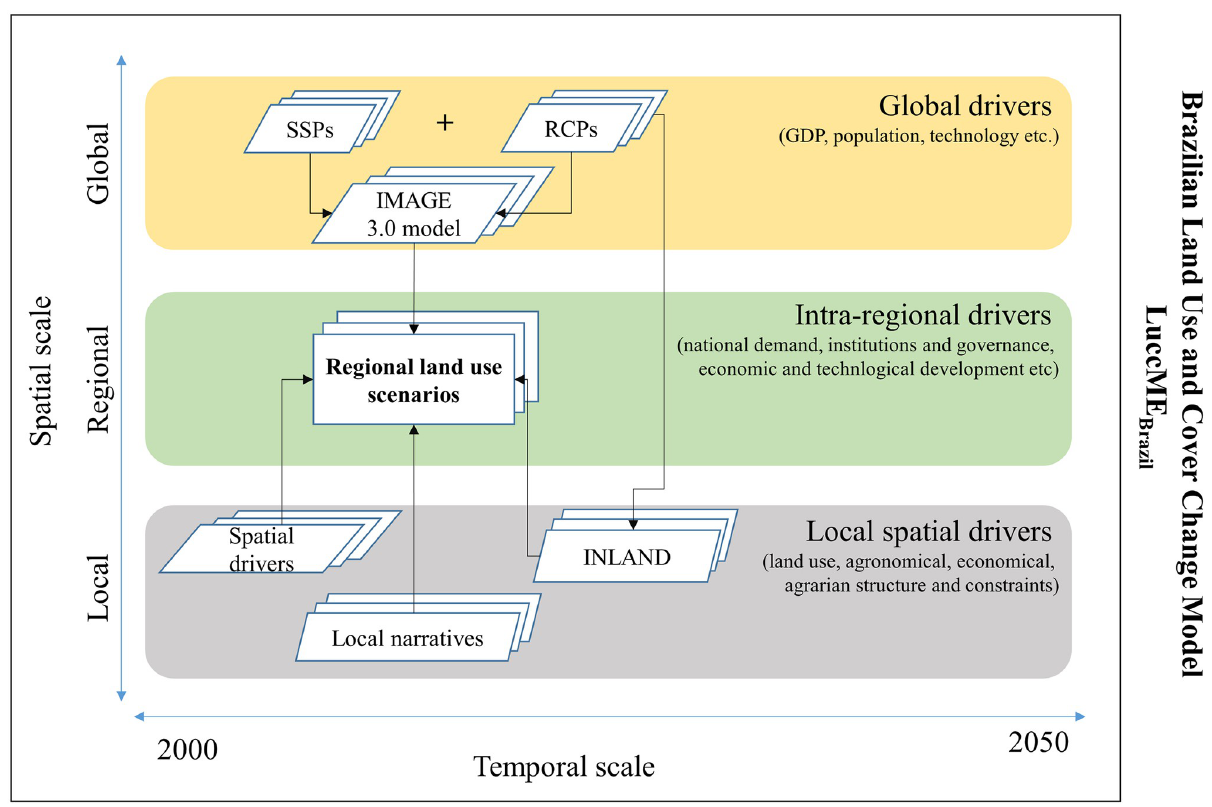
Fig 1. Schematic representation of the development of regional land use and land cover scenarios. Shared Socioeconomic Pathways (SSPs) and Representative Concentration Pathway (RCPs).